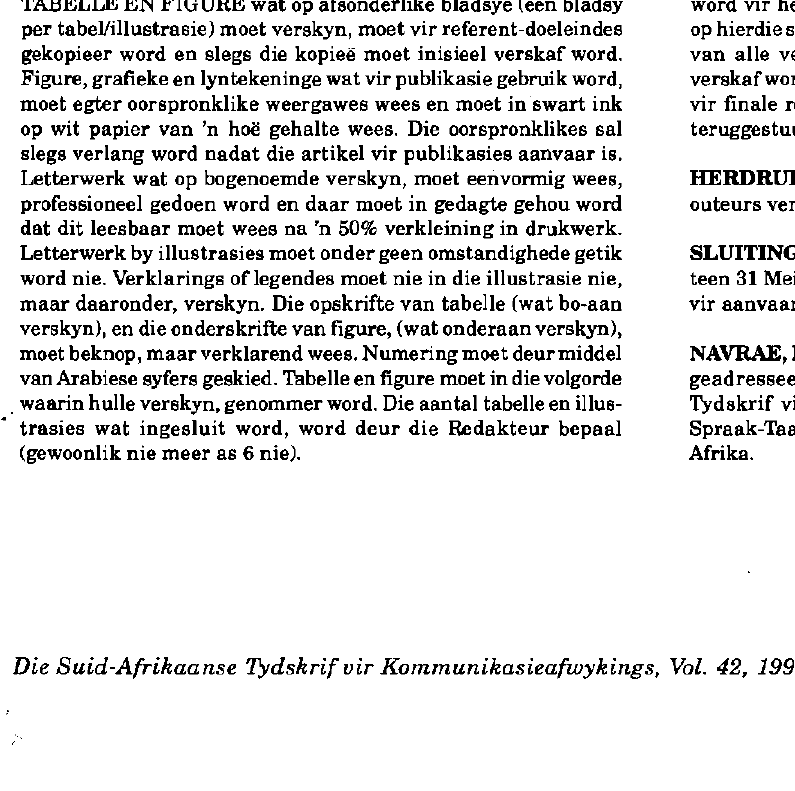
TABELLE EN FIGURE wat op afsonderlike bladsye (een bladsy per tabel/illustrasie) moet verskyn, moet vir